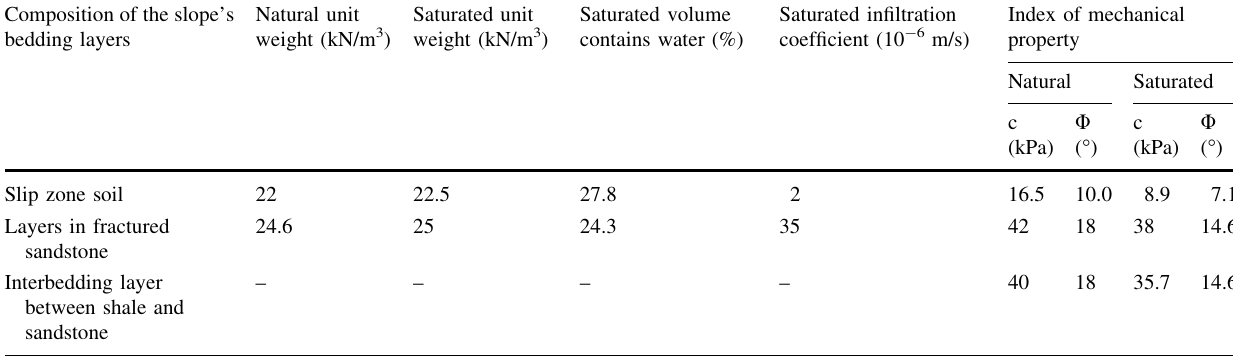
Table 1 Values of the physical and mechanical indices of the slope’s bedding layers. c: Cohesion, A : angle of shearing resistance Source Wang